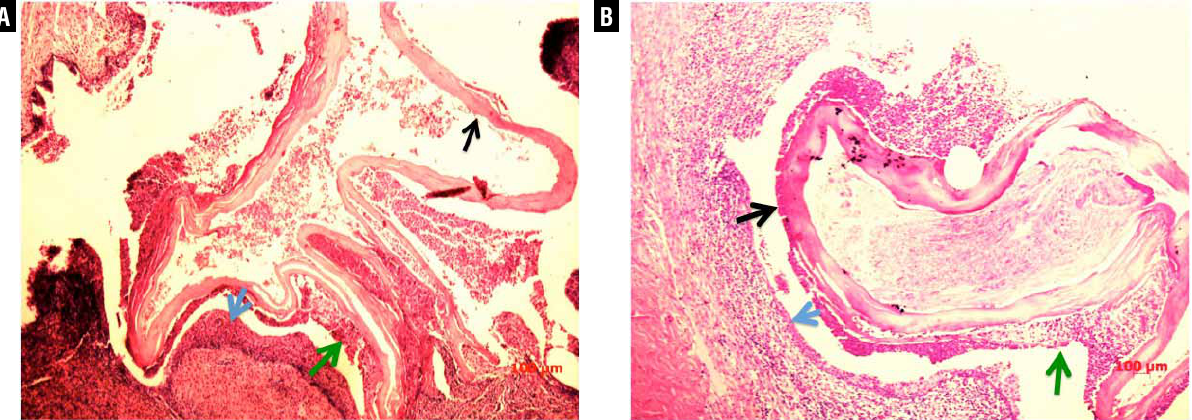
Figure 3 - A - Photomicrography of the urethra - Group I animal, postoperative day 7, Black arrow = Matrix. Green arrow = inflammatory process. Blue arrow = epithelium. H&E 25x. B - Photomicrography of the urethra - Group II animal, postoperative day 7, Black arrow = Matrix. Green arrow = inflammatory process. Blue arrow = epithelium H&E,